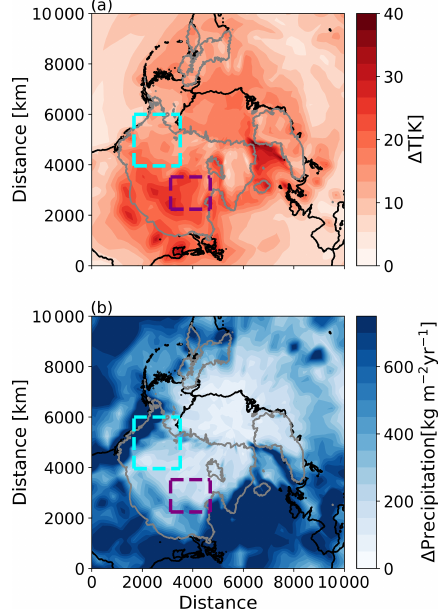
Figure A1. Difference between PMIP4 ensemble maximum and ensemble minimum for (a) surface temperature (b) precipitation. Cyan and purple dashed boxes show Mackenzie and Hudson area, respectively. Grey lines outline ice-sheet extent.